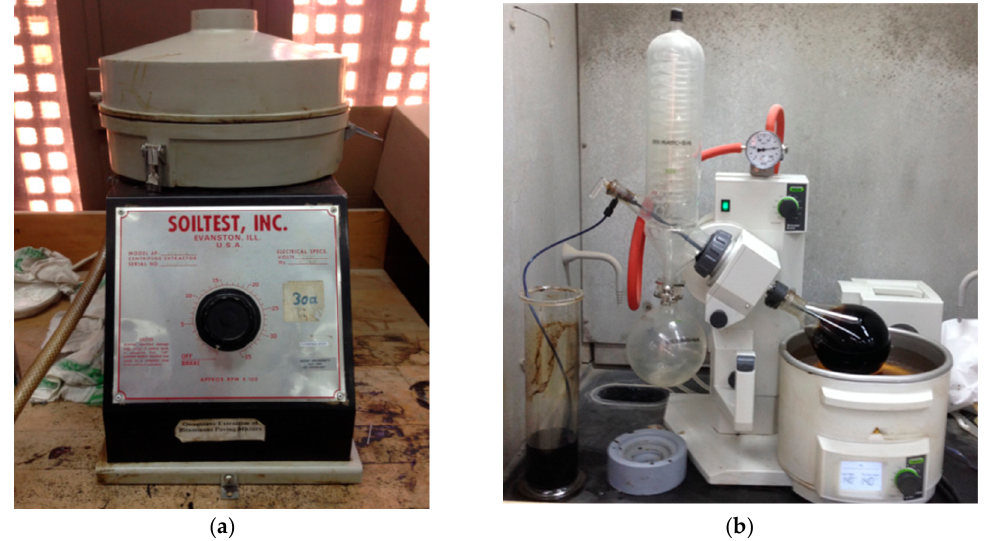
Figure 5. ( a ) Extraction unit and ( b ) rotavapor setup for recovery of asphalt binder from asphalt mixture.